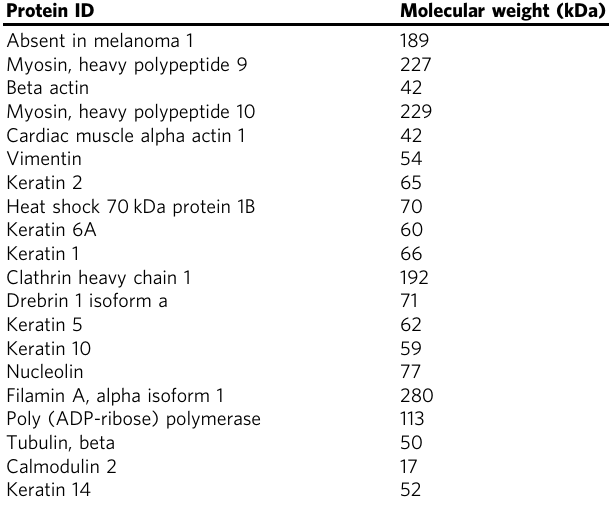
Table 1 Top 20 co-precipitating proteins Protein ID